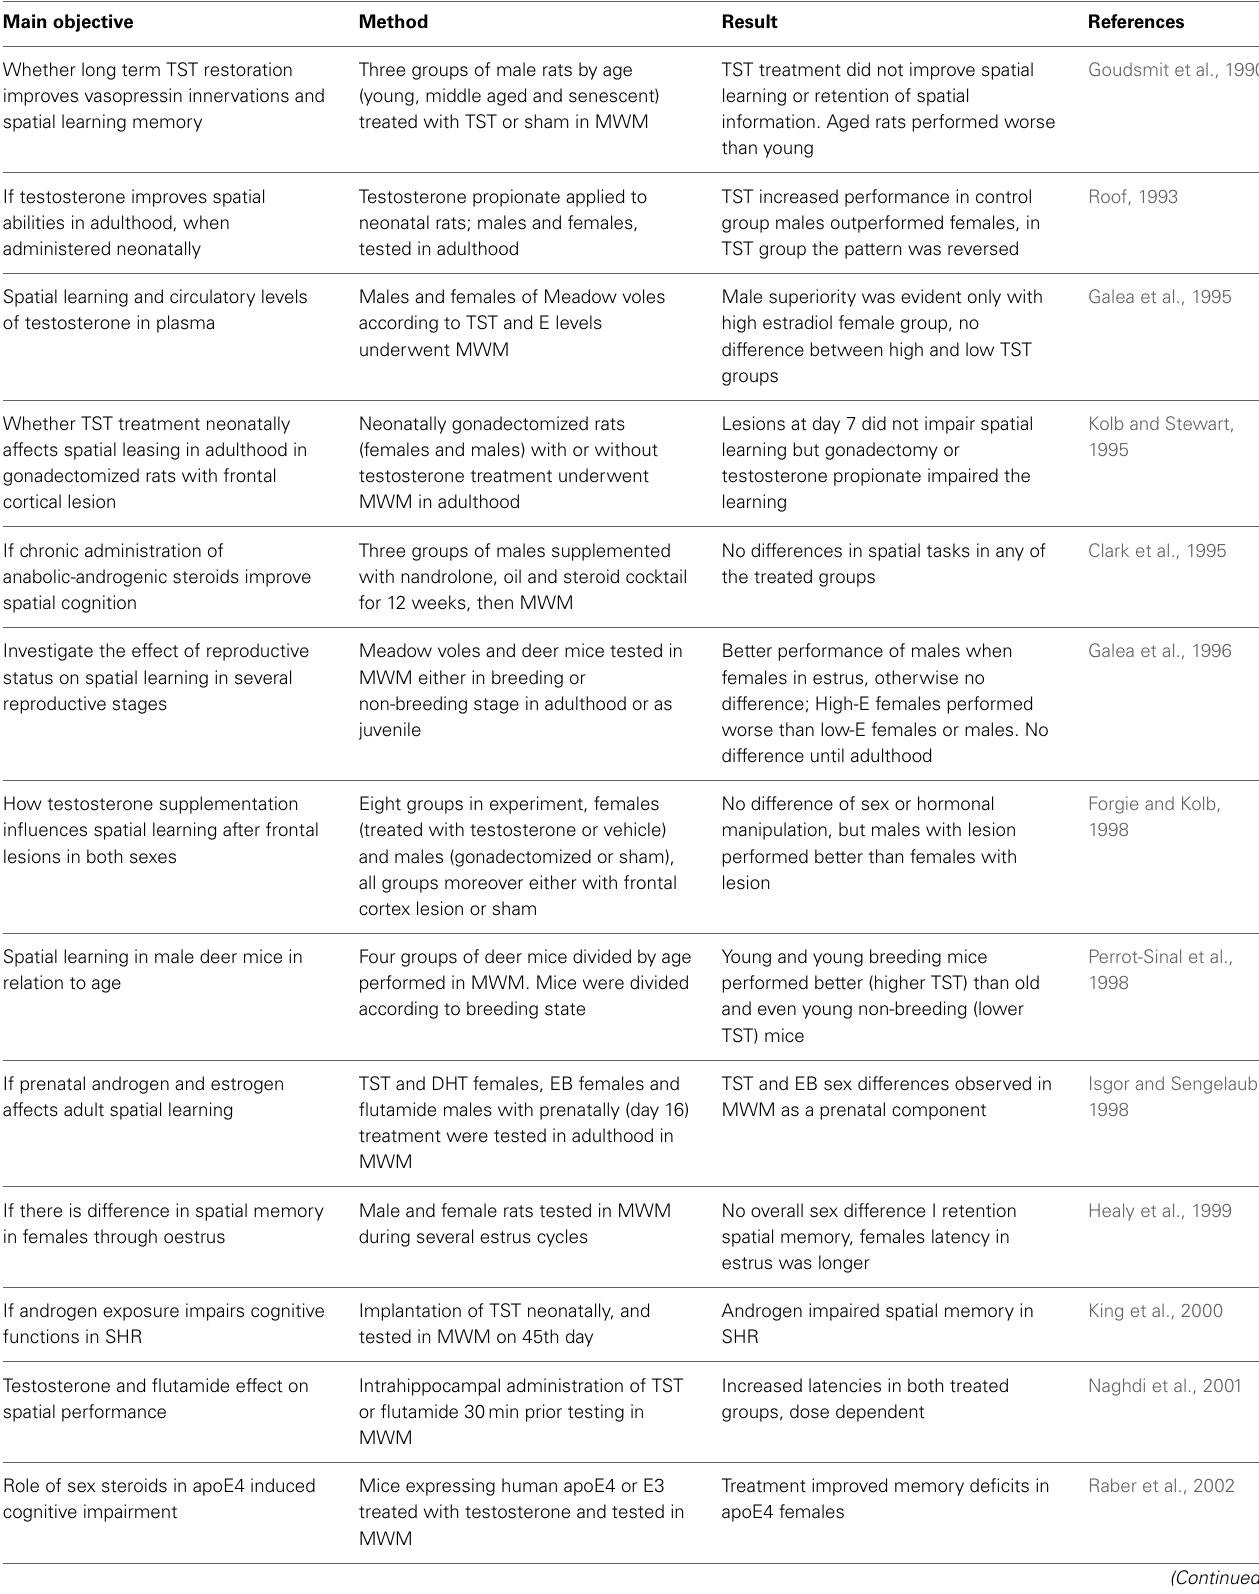
Table 4 | Selected animal studies analyzing the relationship between testosterone and